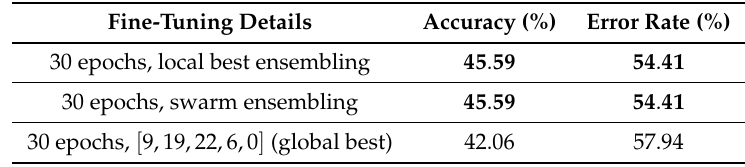
Table 4. Performance measures on the CIFAR-10 test set for 30 fine-tuning epochs following optimisation using no weight inheritance method. With the best results highlighted in bold.